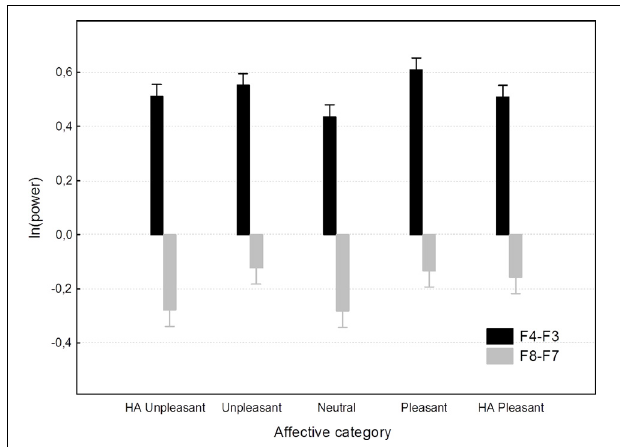
FIGURE 3 | Affective category main effect on F4-F3 and F8-F7 asymmetries. Spreads denote standard errors.